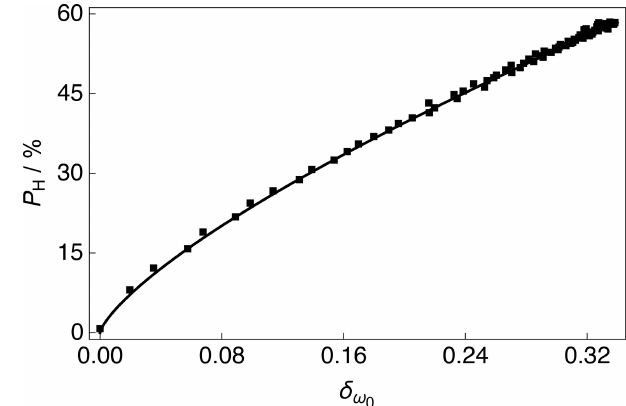
Figure 5. Experimental 1 H polarizations P H as a function of the 13 C NMR peak CoG normalized deviation δ ω acquired at 0 7.05T ( 1 H nuclear Larmor frequency = 300.13MHz, 13 C nuclear Larmor frequency = 75.47MHz) and 1.2K with a single transient per data point for the case of positive microwave irradiation. The experimental data were fitted with a phenomenological function: P H ( δ ω ) = A × δ β ω . The best fit values are A = 129.1% ± 0.8% and 0 0 β = 0.736 ± 0.005. The absolute 1 H polarizations P H were mea- sured by comparison with a thermal equilibrium 1 H NMR